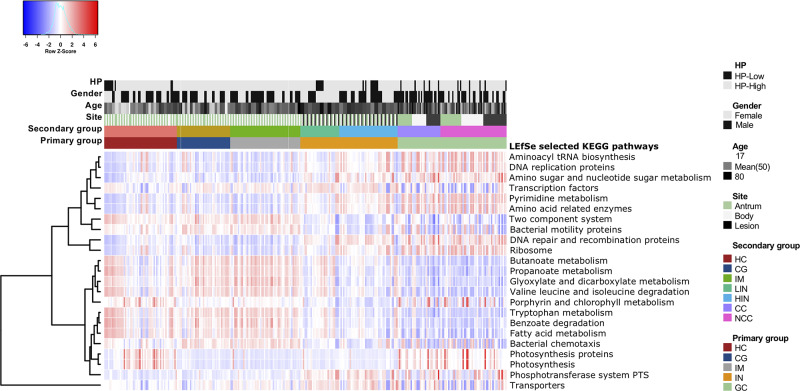
Functional dysbiosis in the gastric microbiota is associated with the progression of gastric carcinoma. Heatmap of differential expression in functional metabolic pathways across stages of gastric carcinogenesis. The KEGG pathways significantly enriched in each disease stage were identified using LEfSe with Kruskal–Wallis test p < 0.05 and log10 LDA score > 3.0.